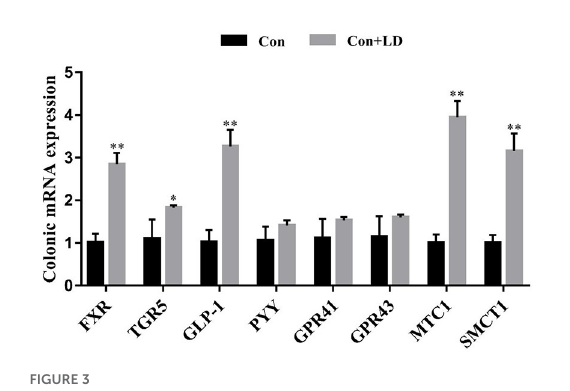
FIGURE3 Colonic gene expression related to SCFAs transport and signal transduction of growing-finishing pigs. Values for histogram are shown as Mean ± SEM, * P < 0.05, ** P < 0.01. FXR , Farnesoid X receptor; TGR5 , G protein-coupled bile acid receptor; GLP1 , Glucagon-like peptide 1; PPY , Peptide YY; GPR41 , G protein-coupled receptor41; GPR43 , G protein-coupled receptor43; MCT1 , Monocarboxylate transporter; SMCT1 , Sodium-dependent monocarboxylate transporter; Con, basal diet; Con + LD, basal diet + 0.1 % L. delbrueckii .